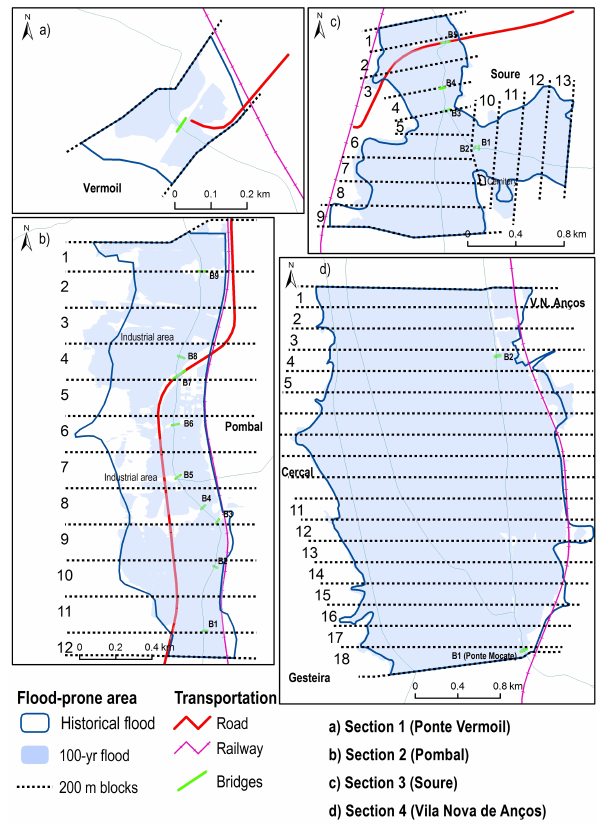
Fig. 9. Flooded areas in the modelled sections defined by both